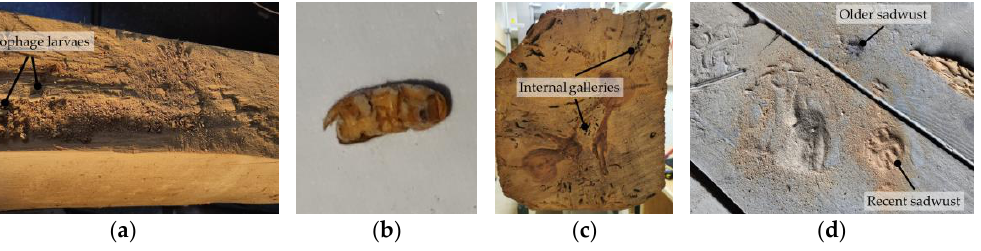
Figure 17. ( a ) Damage, residue and larvae in the wooden beams associated with the presence of xylophages; ( b ) sawdust extracted from the galleries made by the xylophages; ( c ) lots of internal galleries of xylophages (current and in the past); ( d ) xylophage larvae found during inspection.